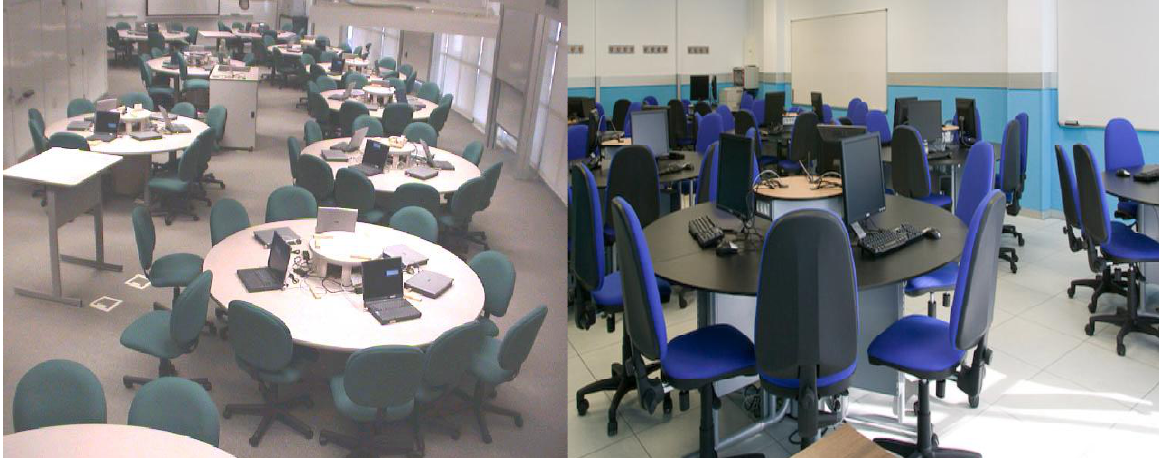
Fig.1. SCALE-UP rooms at North Carolina State University (U.S.A.) and Universidad Politécnica de Madrid,